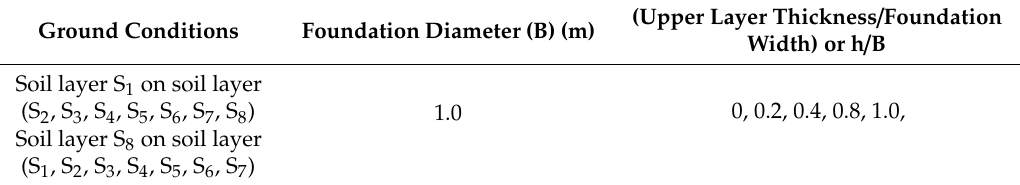
Figure 7. A schematic view of the finite element modeling employed for the current study Table 1. FEM plan used for the input layers’